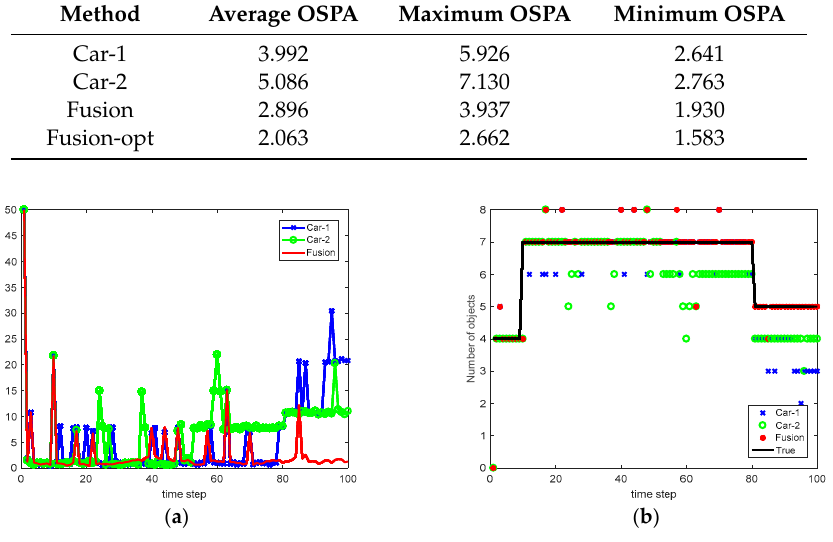
Figure 6. Results in a simulation run ( a ) variation of OSPA distance and ( b ) variation of the number of objects. Table 3. Execution time (ms) for MOT.